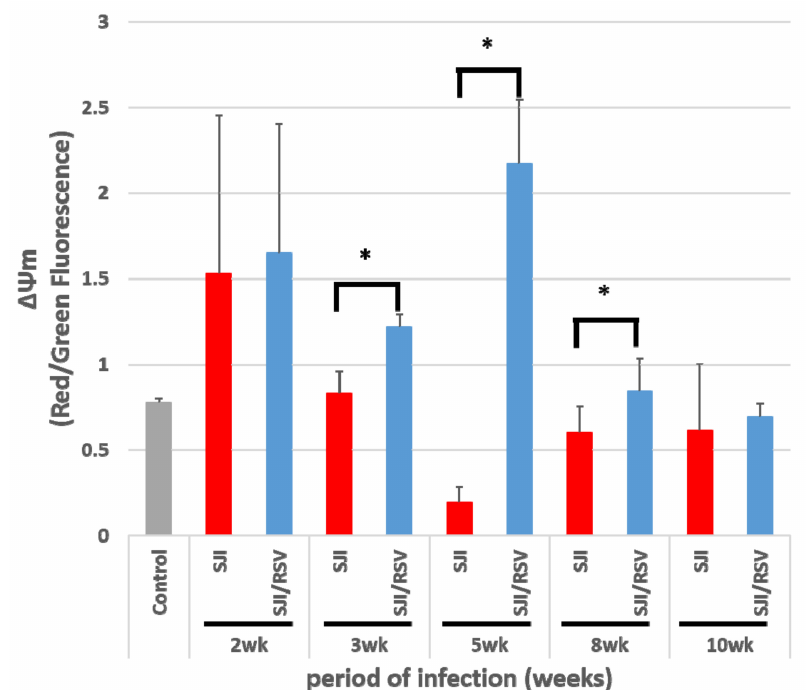
Figure 2. RSV improves the mitochondrial membrane potential ( ∆ ϕ m) of the liver in S. japonicum - infected mice. Representative data from flow cytometry analysis are presented. JC-1 staining of the mitochondria was used to assess the ∆ ϕ m of mice liver. ∆ ϕ m was higher in the RSV-treated group than in the non-treated group (uninfected mice were used as the normal control group). The values are presented as mean ± SD (n = 5). * p < 0.05, unpaired Student t